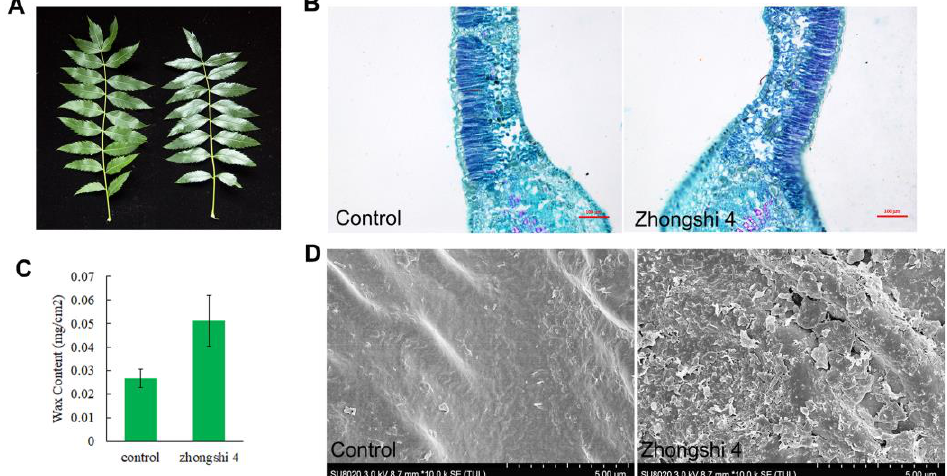
Figure 8. The wax accumulation in the leaves of yellow horn. ( A ) Photographic image of the control (left) and ‘Zhongshi 4’ (right) leaves. ( B ) Anatomical structure characterization of the control and ‘Zhongshi 4’ leaves. ( C ) The wax content in the leaves of the control and ‘Zhongshi 4’. ** indicates significant difference at p < 0.01. ( D ) Wax crystal morphology of the leaves of the control and ‘Zhong- shi 4’ via scanning electron microscopy.